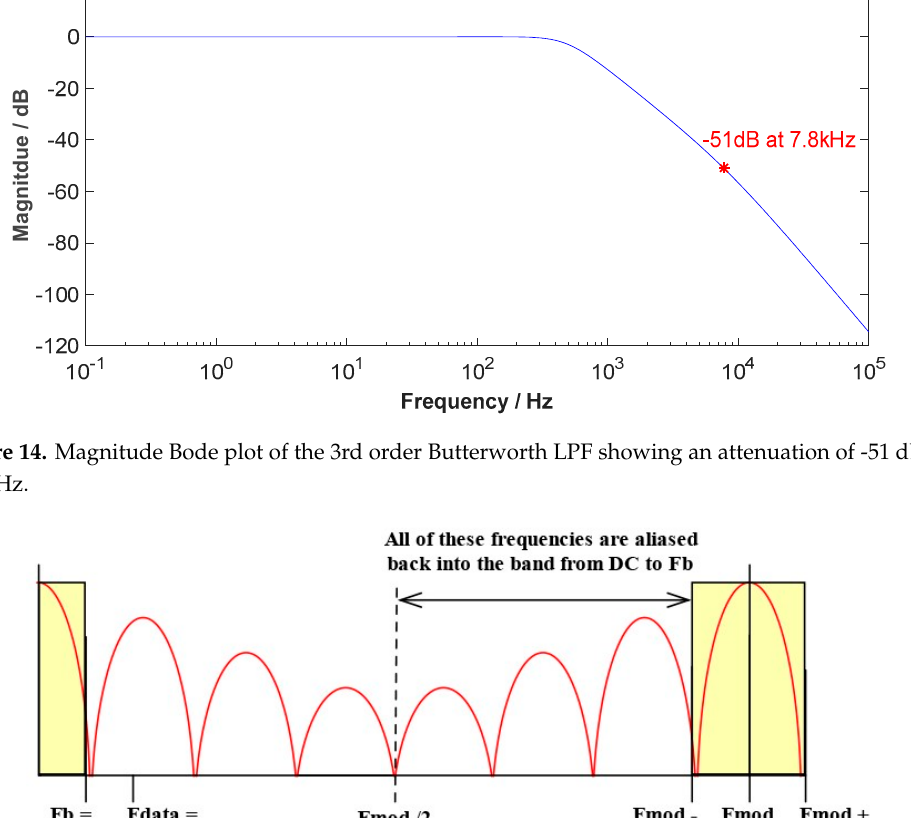
Figure 15. Aliasing of the upper band of frequencies from (F MOD / 2) to (F MOD / 2 – F b ) to the frequency bandwidth of interest from DC to F b . This is problematic and so requires a high order antialiasing low pass filter before digitization.